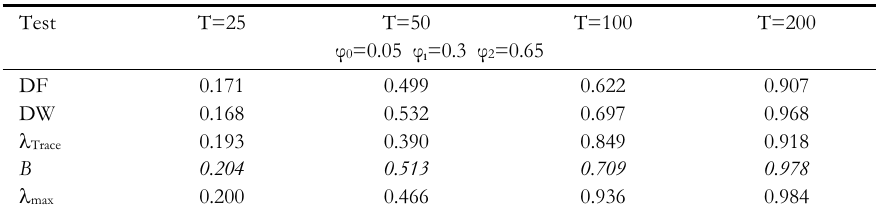
( (cid:438) 0 =0.05 (cid:438) =0.3 (cid:438) 2 =0.65) Estimation of the power of the tests, nominal level 0.95